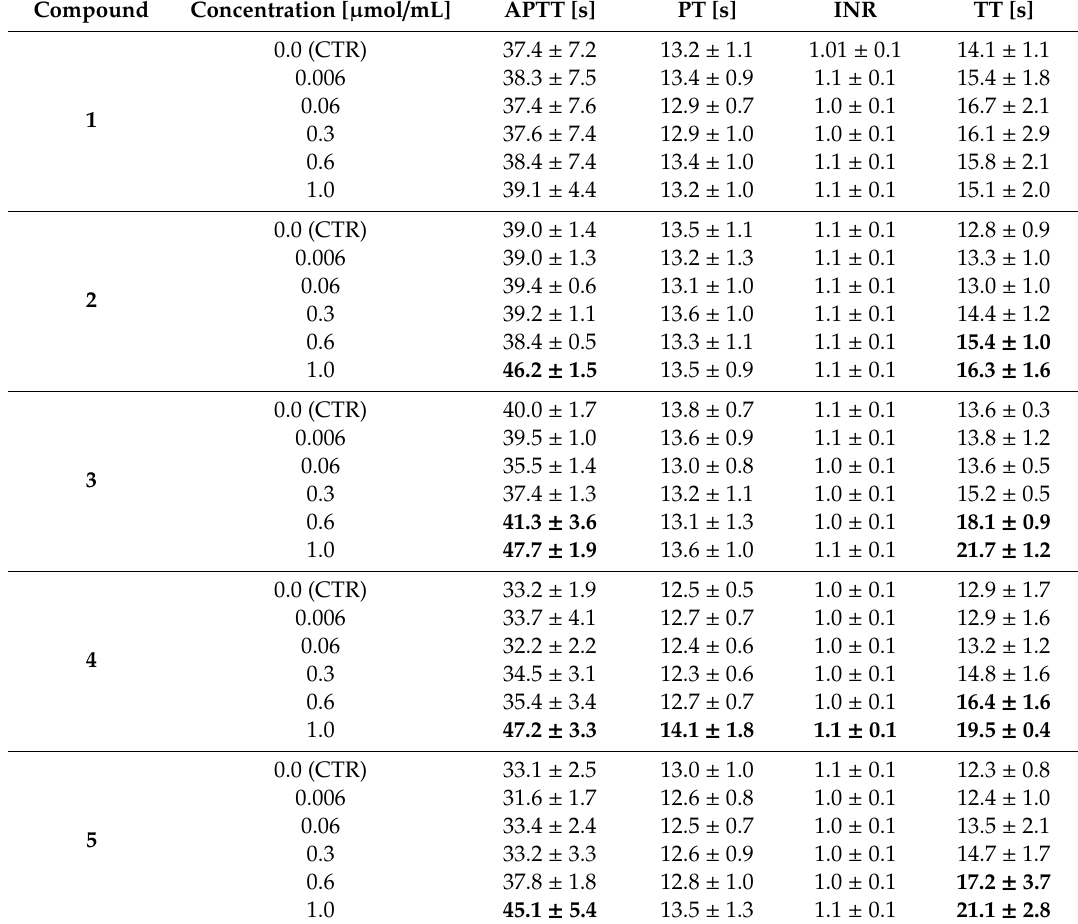
Table 2. E ff ects of synthesized compounds 1 – 10 on basic coagulation parameters. Compound Concentration [ µ mol /